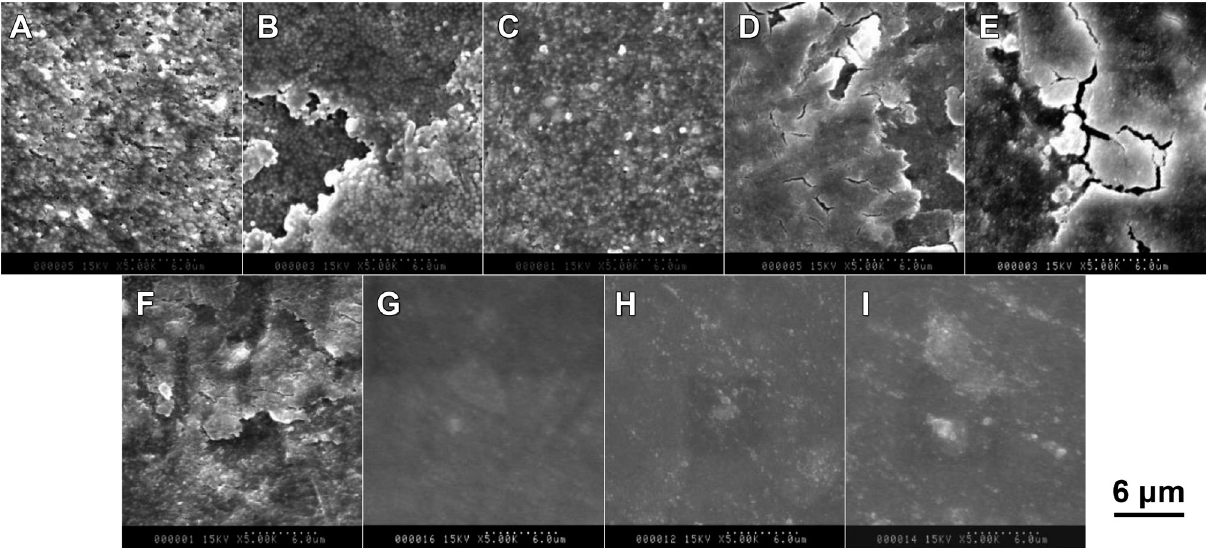
Figure 6- Representative scanning electron microscopy (SEM) photographs of worn material surfaces after 40,000 two-body wear cycles (×5,000 magnification